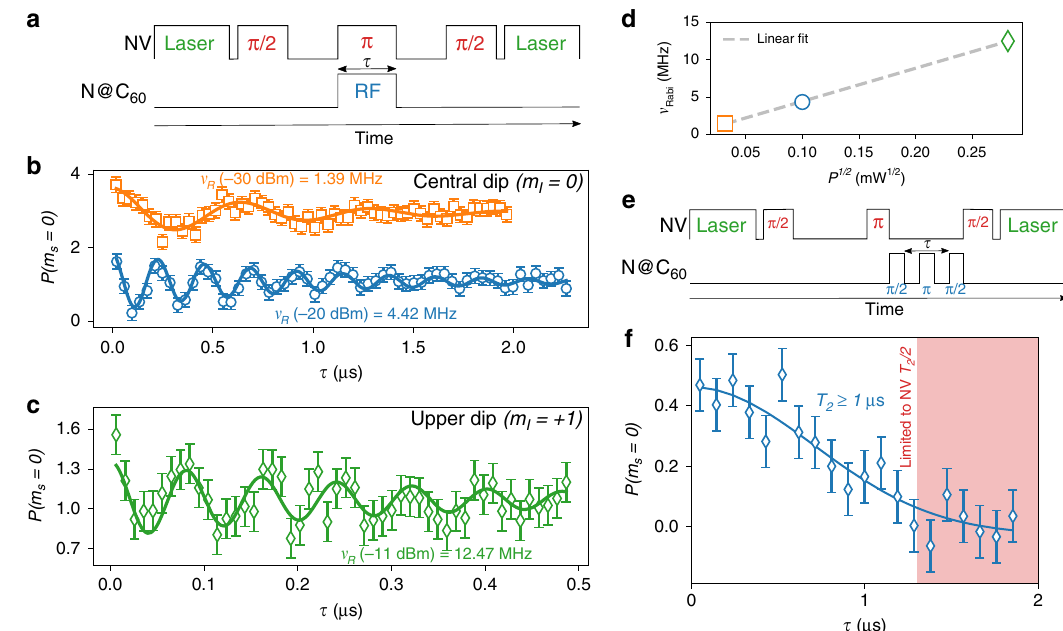
Fig. 3 Relaxation and coherence of an endofullerene spin. a Pulse scheme for driving Rabi oscillations on endofullerene spins and probing with a single nitrogen vacancy (NV) center . b , c Rabi oscillations on the endofullerene central ( m I = 0) and upper ( m I = + 1) hyper fi ne components. Solid line is fi t to an exponentially decaying sinusoid. Error bars indicate photon shot noise. d Characteristic square-root behavior of Rabi frequency with RF driving power. e Pulse scheme for probing endofullerene spin-echo phase coherence. f Spin-echo measurements place a lower limit of T 2 ≥ 1 μ s on the phase coherence times. Solid line indicates exponentially decaying sinusoidal fi t, error bars indicate photon shot